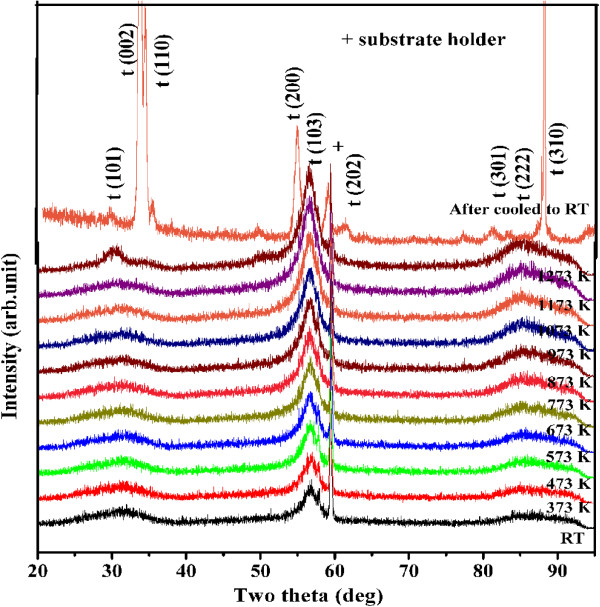
HTXRD pattern of Al2O3/ZrO2film (5:5 nm) in the temperature range 300-1273 K. The peak at 60° (2θ) indicates reflection from the substrate holder.